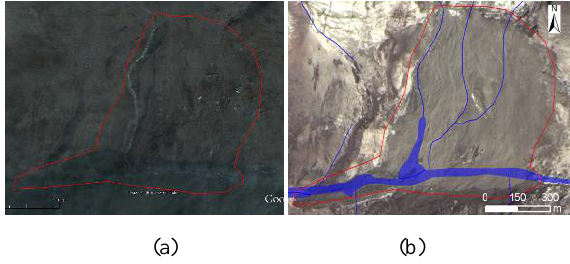
Figure 7. The Langtang landslide. (a) Satellite image from Google Earth taken on January 22, 2015; (b) GF1 (China) satellite image on May 10, 2015